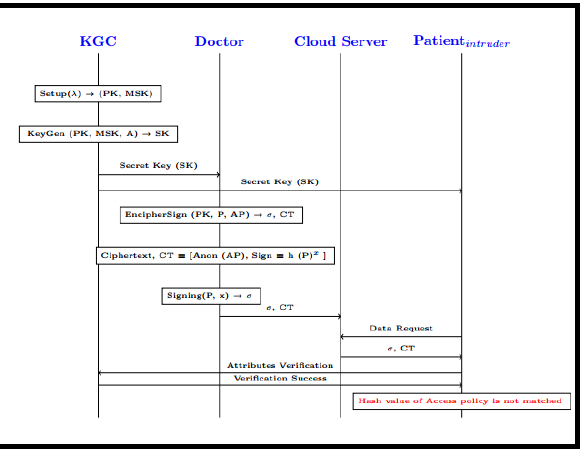
Figure 17. Threat model—hash value of access policy